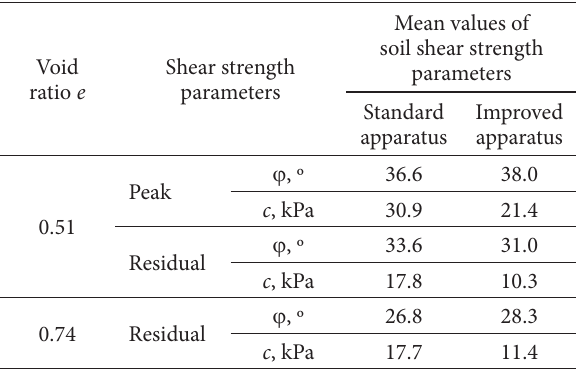
Mean values of soil shear